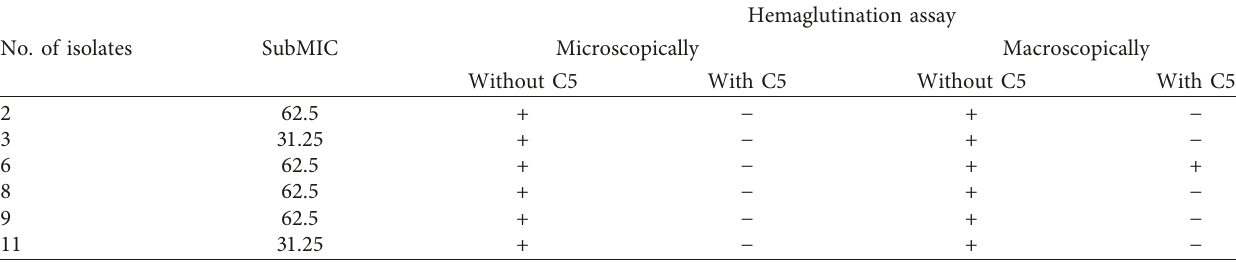
Table 13: The effect of the hydantoin compound C6 on the hemagglutination activity in relationship with S. aureus biofilm formation. No. of isolates SubMIC